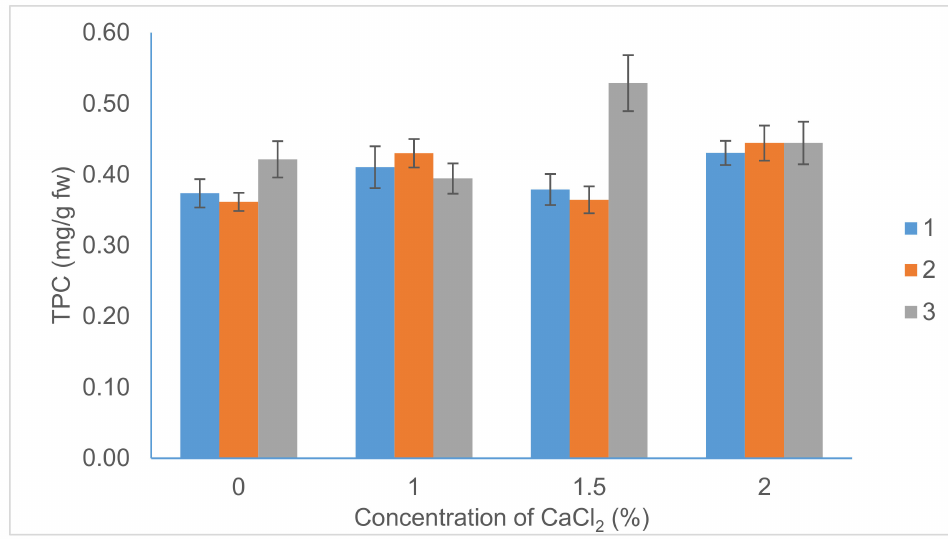
Figure 6. The interaction effects of harvesting stages (1 = green mature, 2 = breaker, and 3 = half-ripe) and CaCl 2 (0, 1%, 1.5% and 2%) on TPC of the tomato fruit stored at ambient temperature (28 ± 2 ◦ C and 75 ± 5% RH). Vertical bars indicate the standard error of means for 4